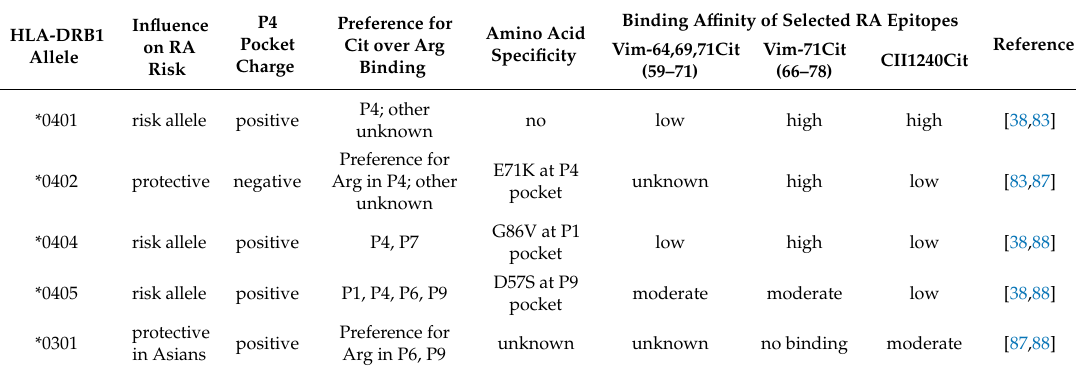
Table 2. Influence of selected HLA-DRB1 alleles and their molecular distinctions on binding a ffi nity. HLA-DRB1 variants di ff er in case of P4 pocket net charge and preference for citrulline in other pockets of the binding groove. The occurrence of specific amino acid substitutions D57S at pocket P9 and G86V at pocket P1 results in slightly di ff erent hierarchies of binding in citrullinated self-peptides between SE